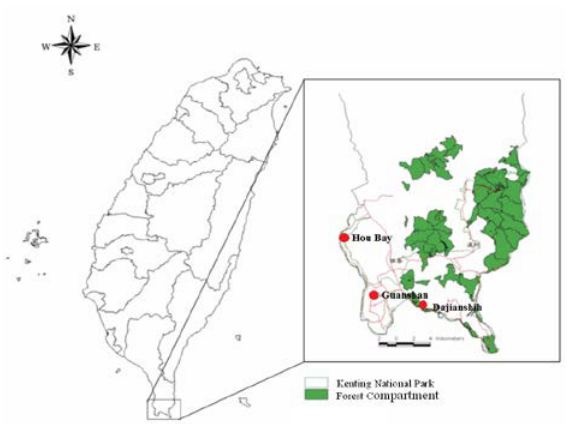
Fig. 1. The sampling sites of the Kenting Nationla Park and Hengchun